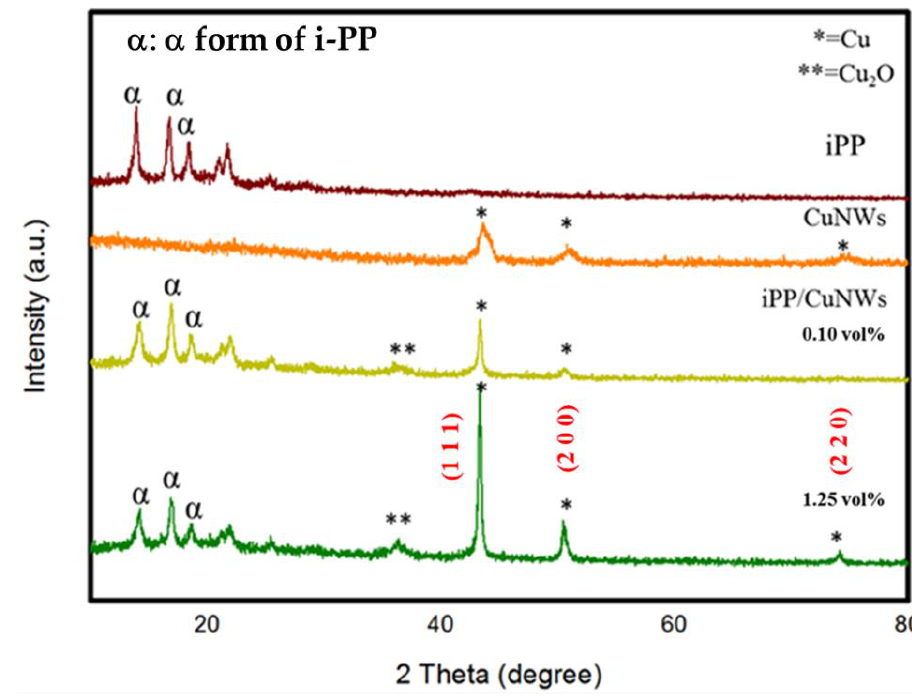
Figure 9. XRD pattern of various i-PP/CuNWs compositions.